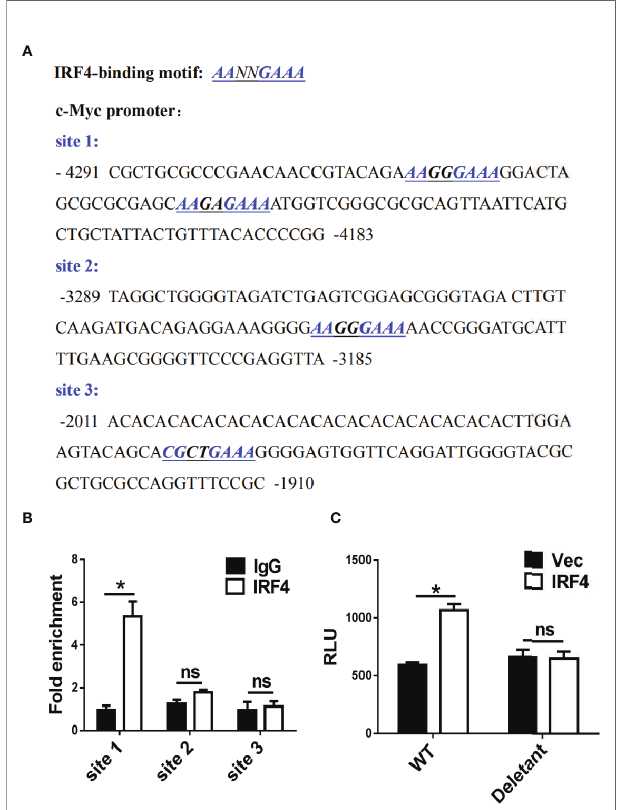
FIGURE 6 | c-Myc is a transcriptional target of interferon regulatory factor 4 (IRF4) in myeloid-derived suppressor cells (MDSCs). (A) Sequence analysis of c-Myc promoter; the potential IRF4-binding sites are underlined. (B) A chromatin immunoprecipitation (ChIP) assay was performed on a 3-day culture of bone marrow (BM) cells using anti-IRF4 or anti-IgG antibodies; the presence of the c-Myc promoter harboring the potential IRF4 binding sites (site 1: − 4,291~ − 4,183) was measured by qPCR. Site 2 ( − 3,289~ − 3,185) and site 3 ( − 2,011~ − 1,910) were detected in parallel as controls. The data were normalized against input and presented as the fold increase over the IgG control. (C) 32D cells were co-transfected with the c-Myc reporter (WT, +157 ~ − 4,480) or deletant (+157 ~ − 3,573) and the plasmid expressing IRF4 or vector; luciferase activity was measured 48 h posttransfection. (B, C) Mean ± SEMs from three independent experiments; * P < 0.05, ns P > 0.05, unpaired t